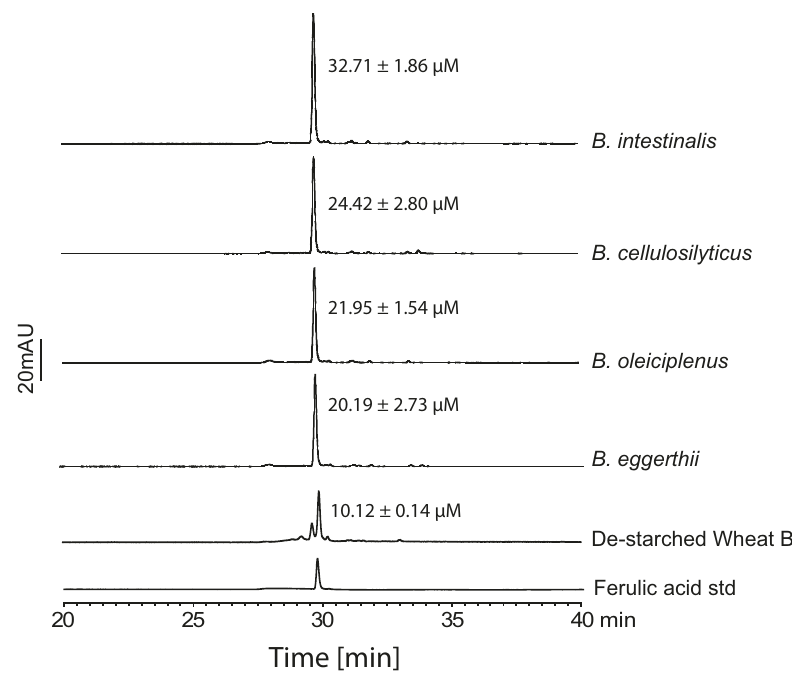
Fig. 9 Growth of diverse Bacteroides spp. in minimal medium containing de-starched wheat bran as the sole carbon source. HPLC-DAD chromatogram of B. intestinalis , B. cellulosilyticus, B. oleiciplenus , and B. eggerthii spent medium from growth on de-starched wheat bran as the sole carbon source showing release of ferulic acid into the medium. The de-starched wheat bran trace shows concentration of free ferulic acid in medium without bacterial inoculation (as control). The results are presented as the mean ± the standard deviation of three independent reactions ( n = 3), and the traces are representatives of the three different reactions. The source data underlying Fig. 9 are provided in the Source Data fi